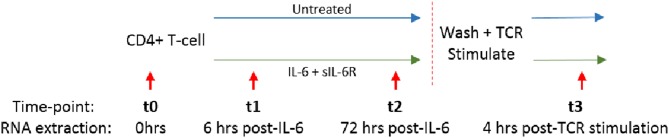
Naïve or memory CD4+ T cells were isolated from 3 healthy donors and cultured with 0.5 ng/ml IL-6 and equimolar sIL-6R for 72 h prior to washing and stimulation with 0.2 μg/ml anti-CD3 and 1 μg/ml anti-CD28 for 4 h. RNA was extracted at baseline (t0), after 6 or 72 h exposure to IL-6 (t1, t2) and 4 h post-TCR stimulation (t3) as depicted by the red arrows.